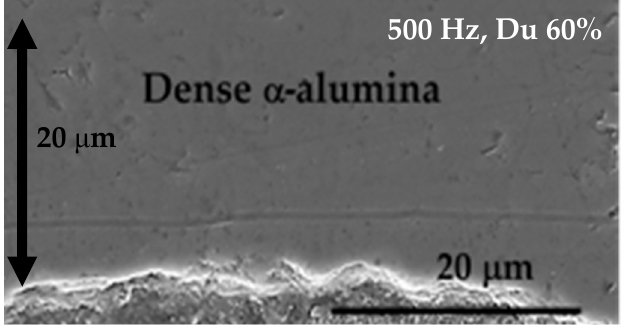
Figure 9. SEM image of cross-section of alumina layer on the Ti alloy formed by MAO of CS-Al layer at pulse frequency of 500 Hz and at duty cycle of 60% for 60 min. Reproduced from [102] with permission from [102].